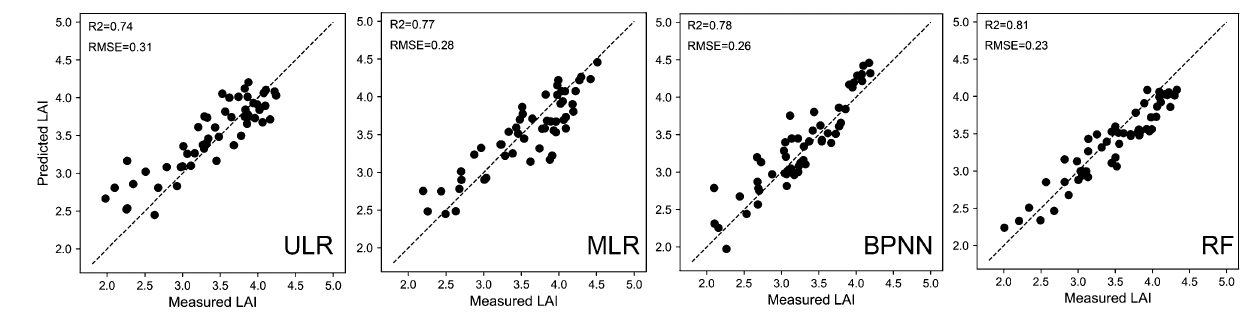
Figure 7. Comparison between the predicted LAI and measured LAI with different regression